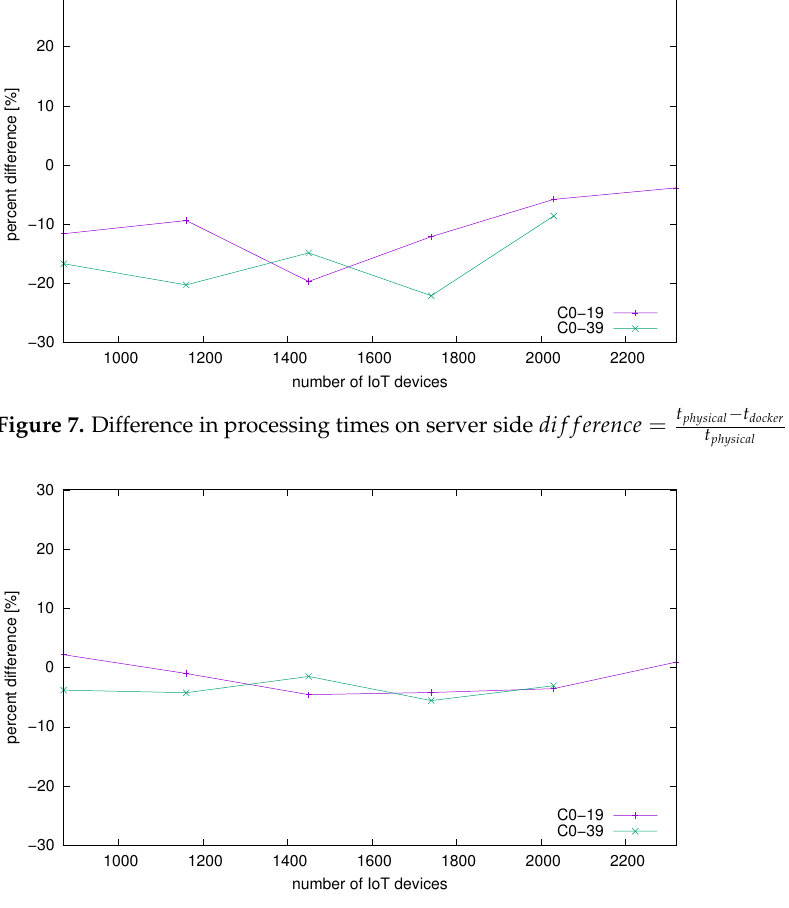
Figure 8. Difference in processing time on client side dif ference = t physical